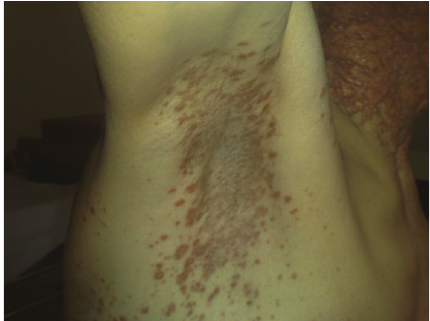
Figure7:Adensedermaldiffusehistiocyticinfiltrationinterspersed with mixed inflammatory cells and giant cells.